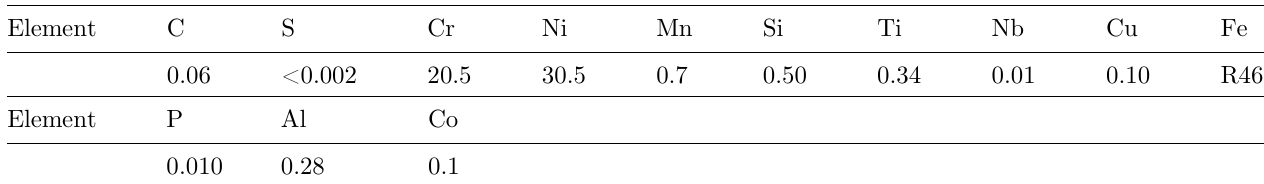
Table 5. Chemical composition of alloy 800 H (wt.%).